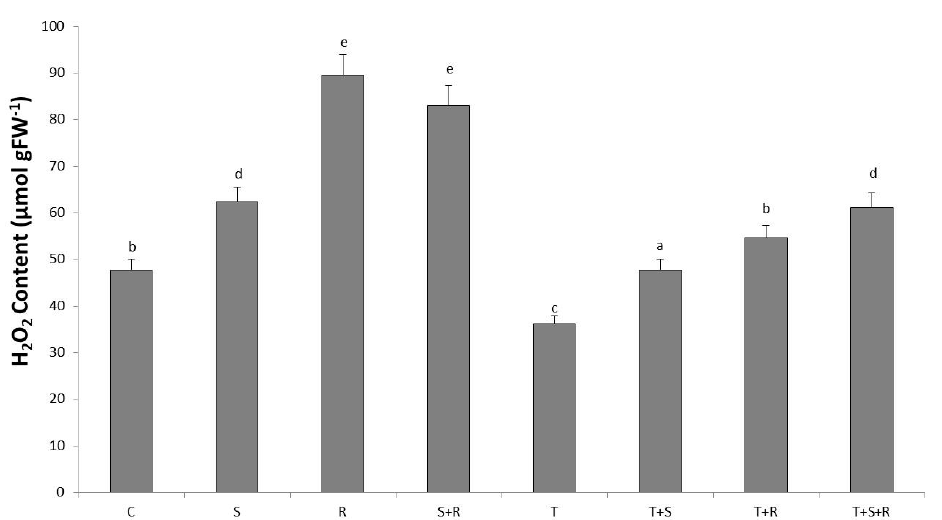
Figure 5. The effect of T. citrinoviride on H 2 O 2 content in the leaves of strawberry plants which were subjected to abiotic stress (40 mM NaCl) and biotic stress (R. solani) either separately or in combination. Different letters indicates significant differences between treatments ( p < 0.05). C, control; S, NaCl-treated; R, R. solani -infected; S + R, Salt stress + R. solani; T, T. citrinoviride- treated; T + S, T. citrinoviride + NaCl; T + R, T. citrinoviride + R. solani ; T + S + R, T. citrinoviride + NaCl + R. solani